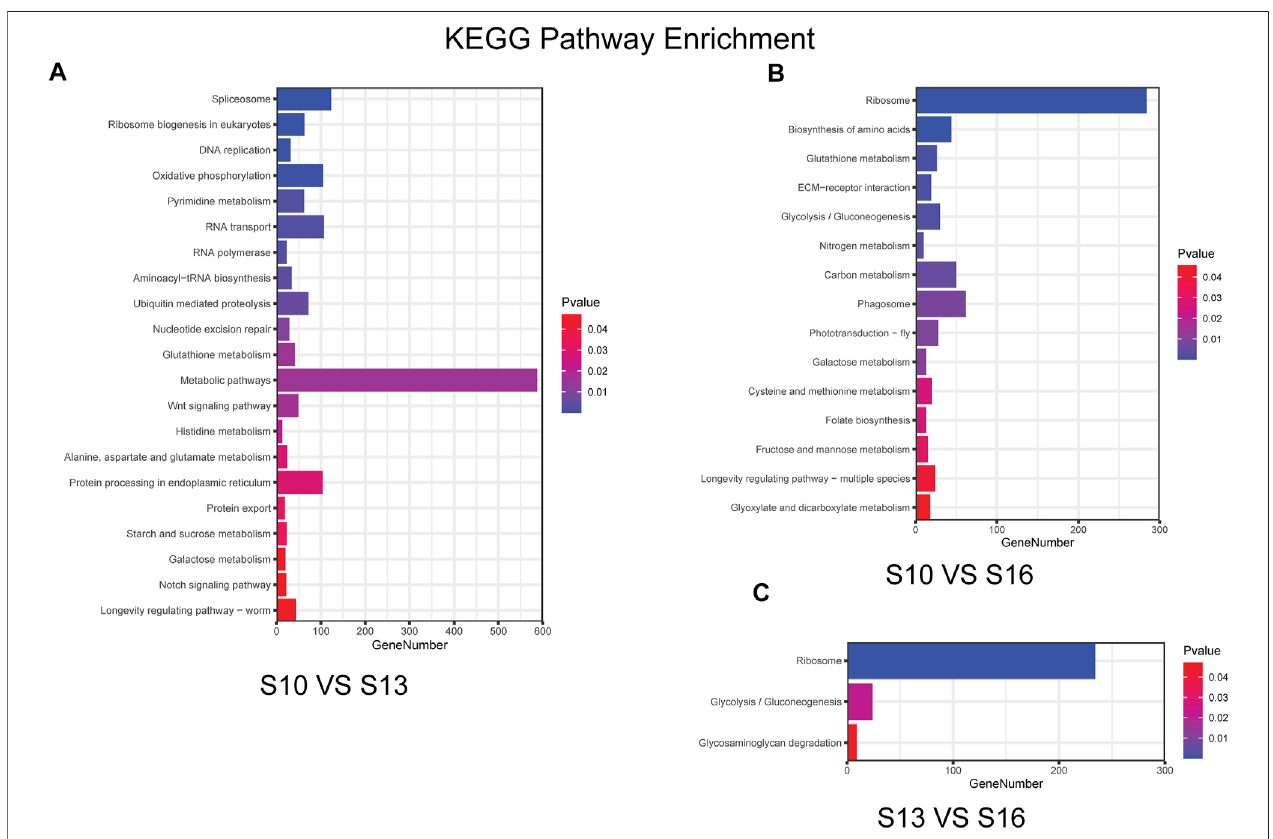
FIGURE 4 | Histogram of the KEGG enrichment results for the S10 vs. S13 comparison (A) , S10 vs. S16 comparison (B) and S13 vs. S16 comparison (C) .